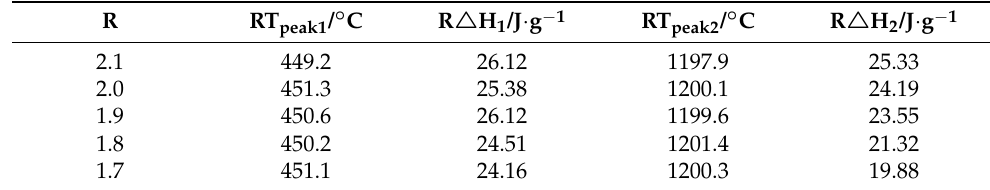
Table 2. Endothermic peak temperature and heat of materials with different basicity